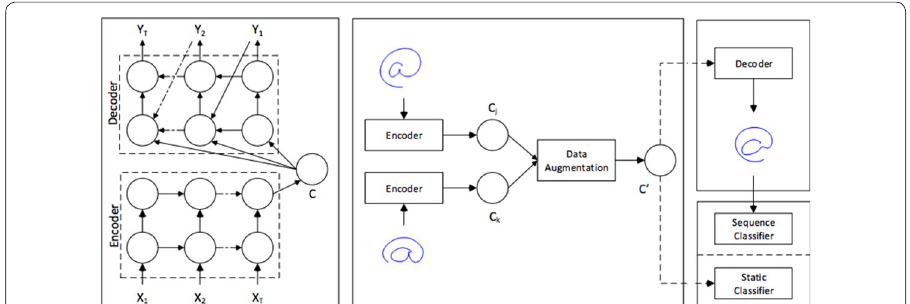
Fig. 13 Architecture diagram of the feature space augmentation framework presented by DeVries and Taylor [75]